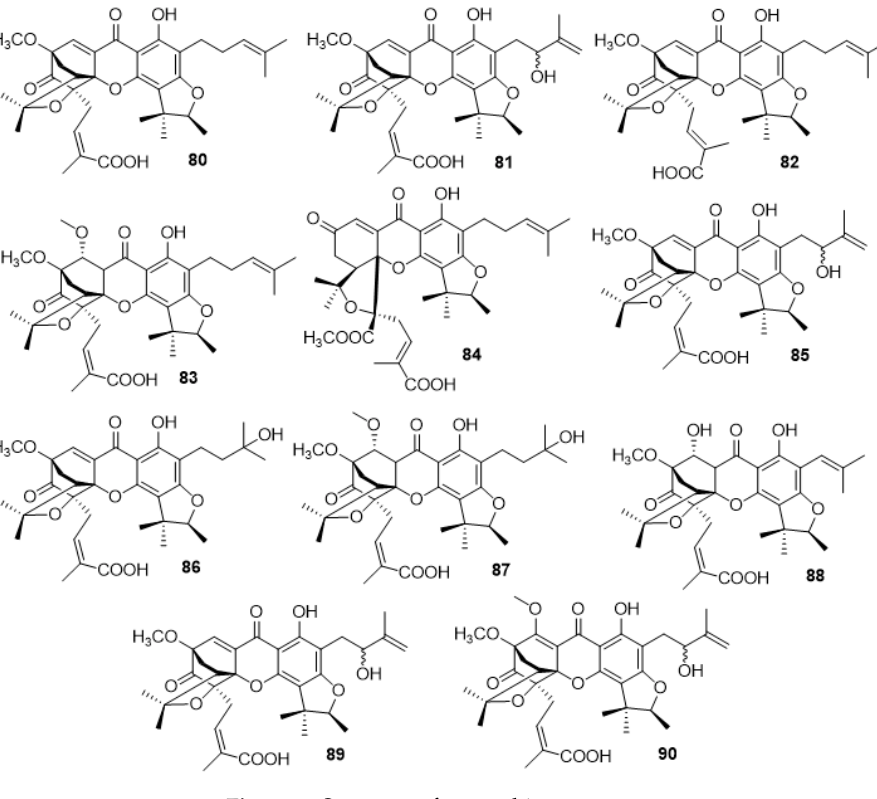
Figure 6. Structure of scortechinones 80 – 90 .